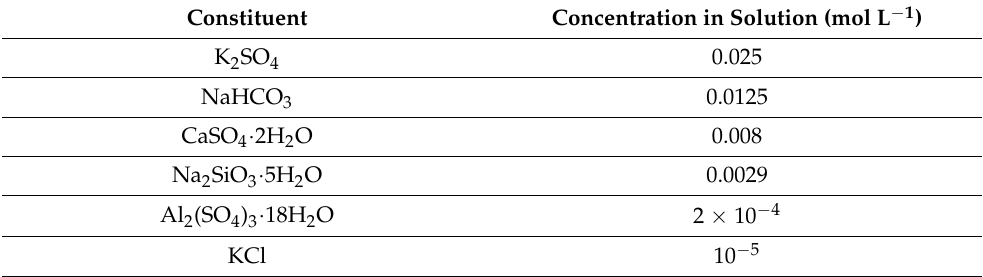
Table 3. Composition of the solution used for the corrosion